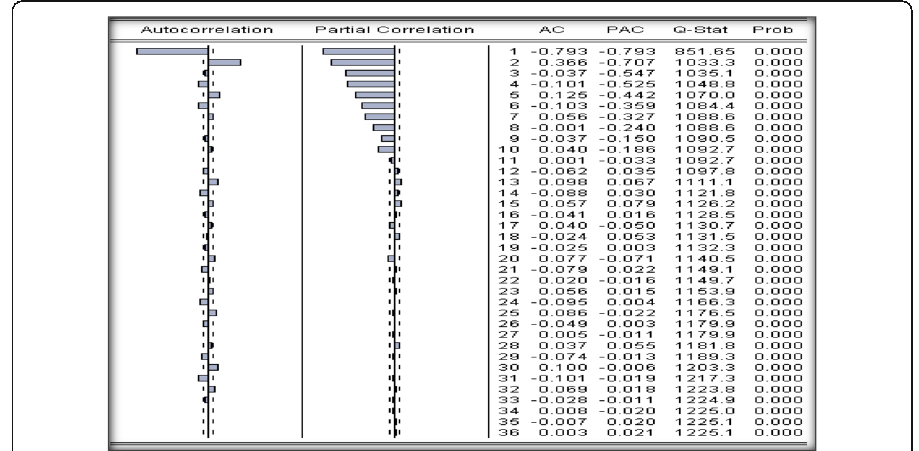
Fig. 9 Correlogram of R*SHARES GETF. The correlogram displays a character-based plot of the Autocorrelations, Partial autocorrelations and the Portmanteau (Q) statistics of the difference in log price of R*SHARES